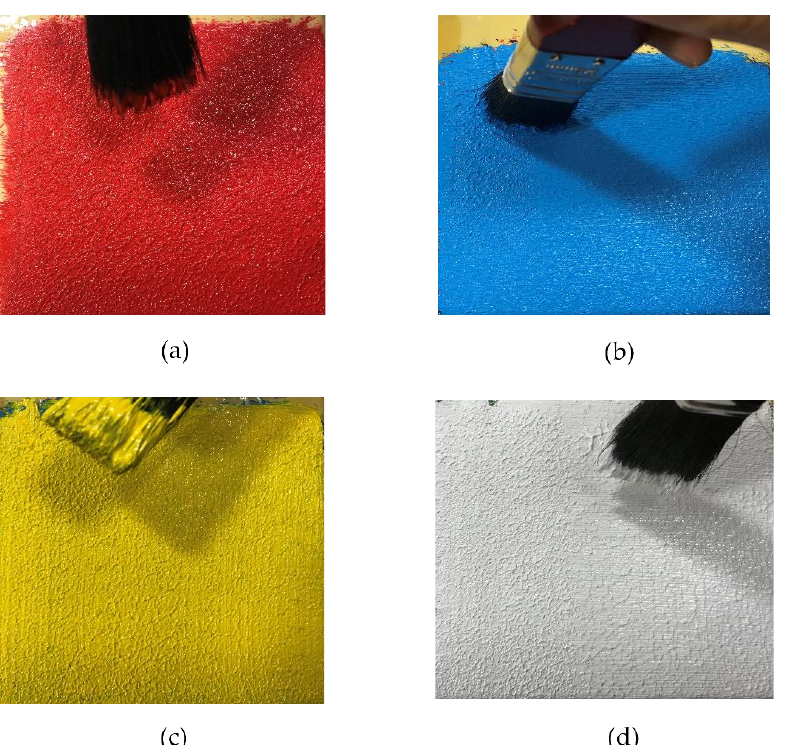
Figure 6. Four steps of applying paints: ( a ) Step 1 (red color), ( b ) Step 2 (blue color), ( c ) Step 3 (yellow color), and ( d ) Step 4 (white color).